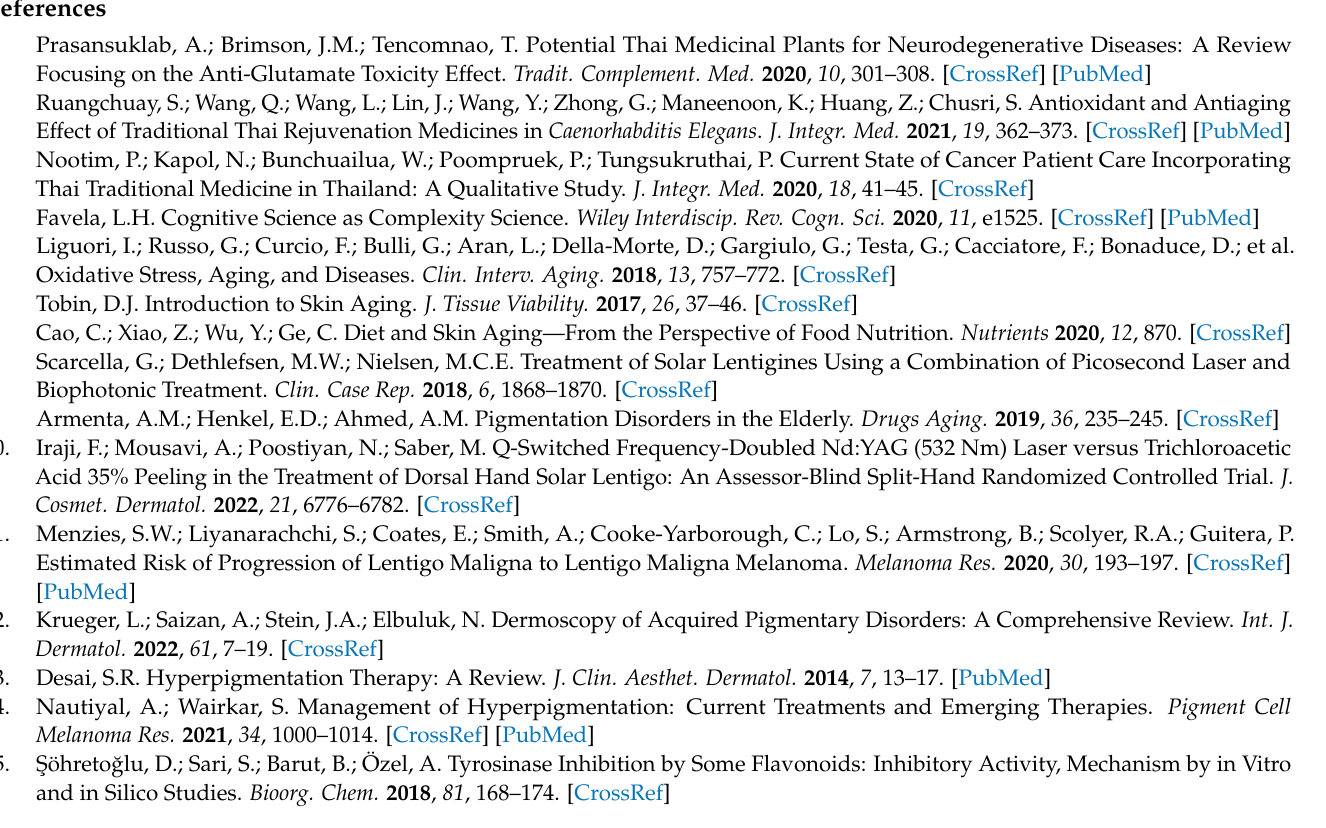
Figure S12: Combining docking results between zebrafish MC1R and ethyl- p -methoxycinnamate derivatives; Table S1: Anti-mushroom tyrosinase screening of sixty-two Thai rejuvenating reme- dies; Table S2: Intercellular melanin content of B16F1 cells treated with α -MSH, positive controls (arbutin, kojic acid, and A. lacucha wood, water extract), and test samples (crude, hexane, ethyl acetate, and ethanol extracts of the selected remedy); Table S3: Cell viability test of arbutin up to 200 µ g/mL concentration; Table S4: Anti-zebrafish pigmentation of all samples; Table S5: Accession numbers of all tyrosinase amino acid sequences used in this study; Table S6: Chemical list in the PubChem